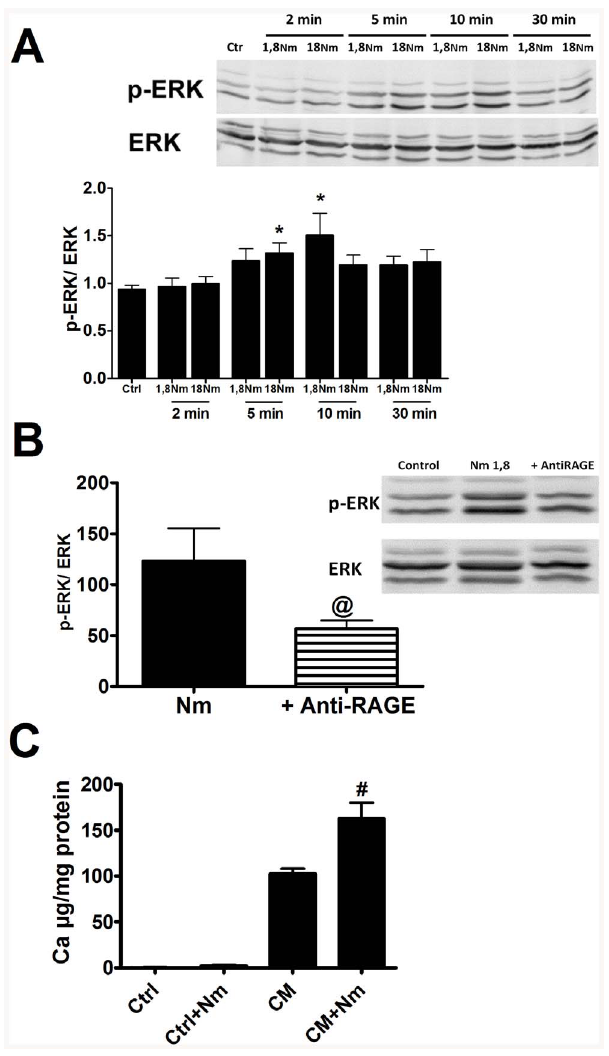
Figure 3. Impact of N-methylpyridinium on VSMCs. (A) P-ERK/ ERK expression ratio after incubation with N-methylpyridinium at two concentrations (1.8 and 18 m g/mL) during 2 to 30 minutes (* p , 0.05 vs Ctrl). (B) P-ERK/ERK expression ratio after 10-minute incubation with N- methylpyridinium (1,8 m g/mL) with or without anti-RAGE antibody (@ p , 0.05 vs N-m 1,8, unpaired t test). ( C ) Enhancement of calcification by N-methylpyridinium (18 m g/mL) ( # p , 0.01 vs CM).